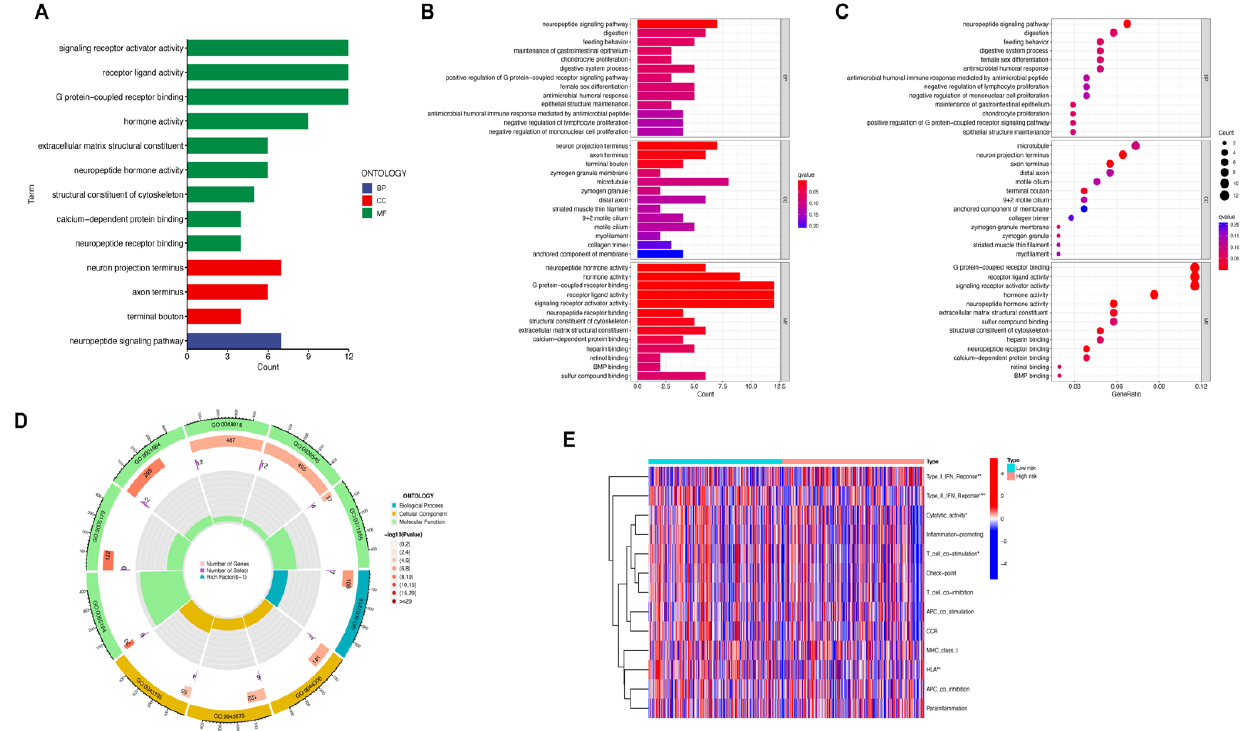
Figure 6. Functional enrichment and immune function analysis. ( A – D ) Gene ontology enrichment analysis of DEGs. ( E ) Immune function analysis of DEGs.